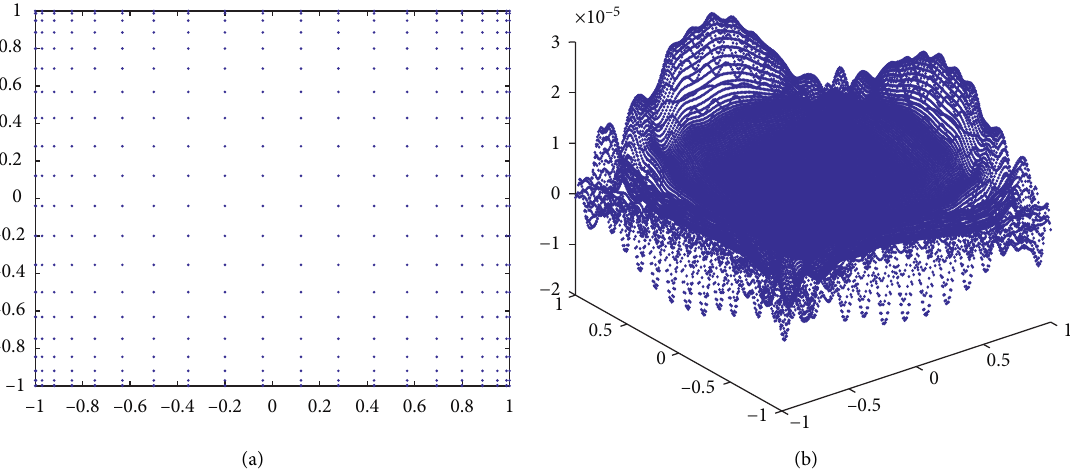
Figure 2: Configuration of the source points (a) and the corresponding absolute errors (b) for the